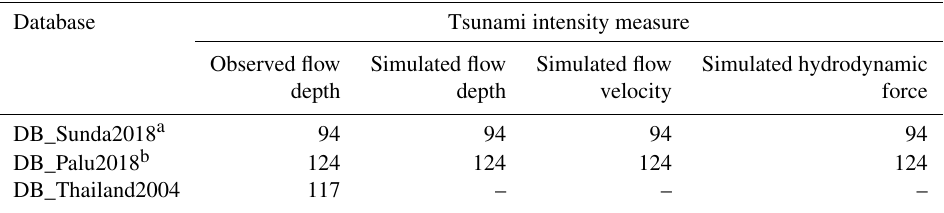
Table 4. Number of buildings used for the tsunami fragility analysis of the 2018 Sunda Strait, 2018 Sulawesi–Palu, and 2004 IOT (Khao Lak–Phuket) events.